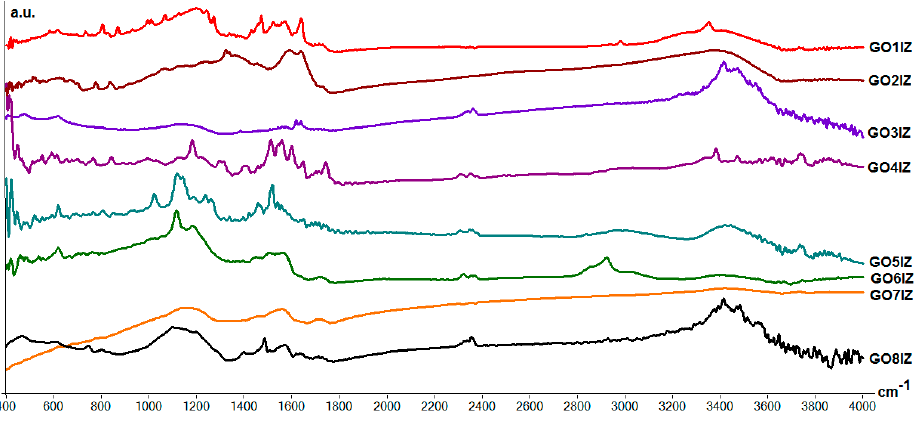
Figure 3. IR spectra of the materials GO1IZ – GO8IZ.